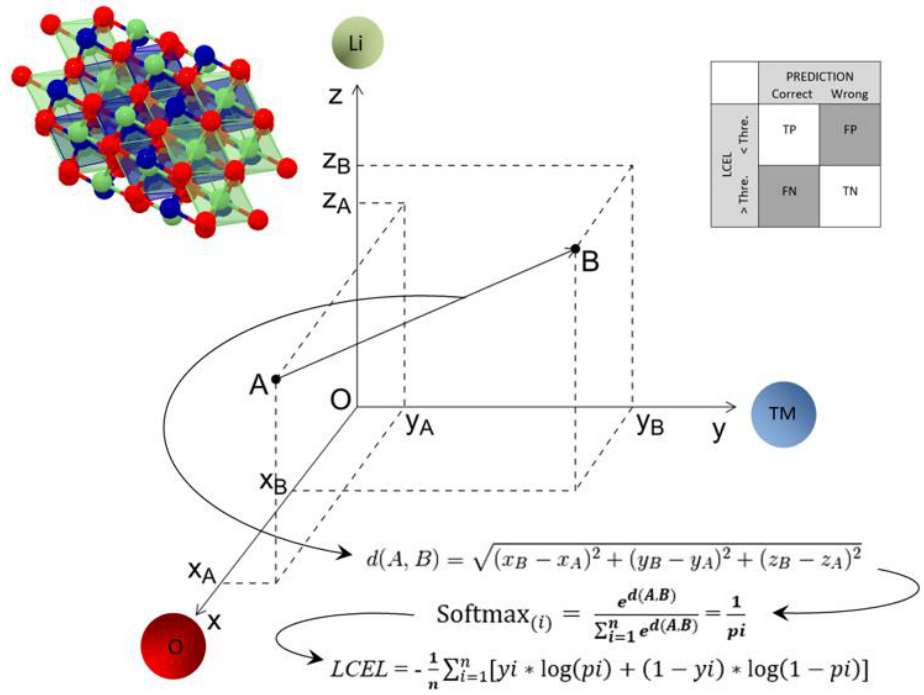
Figure 1. Sketch describing the workflow of the forecasting process. To predict the space group of the test compound (in this case, the LiCoO 2 shown in the upper right corner), the Euclidean distance between the stoichiometric coefficients of lithium (Li), oxygen (O), and transition metal (TM) of the test (A) and the training (B) compounds was calculated. The distance was transformed in a probability using the Softmax equation. The LCEL was used as threshold to evaluate the goodness of the prediction via the confusion matrix shown in the top right corner.